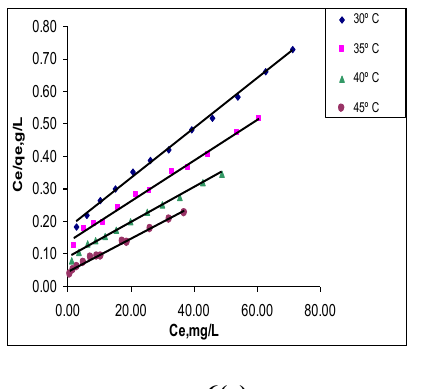
196.08 mg/g for TPAC and 294.12 mg/g to 344.83 mg/g for PPC respectively